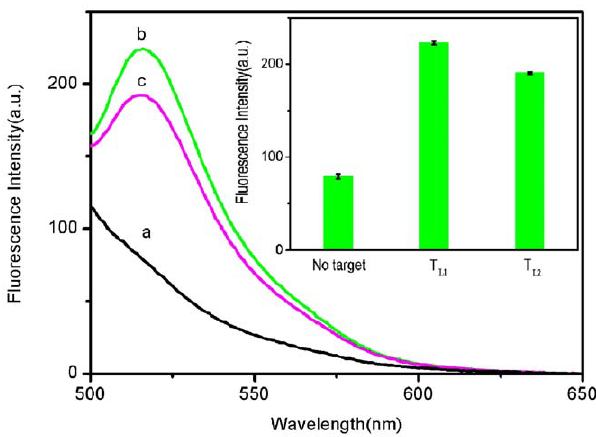
Figure 7. Evaluation of discrimination ability using longer target. Fluorescence emission spectra of P HIV (50 nM) in the presence of 40- m L RCPNs at different conditions: (a) P HIV -RCPN complex; (b) P HIV - RCPN complex + 300 nM T L1 ; (c) P HIV -RCPN complex + 300 nM T L2 . Inset: fluorescence intensity histograms with error bar. Excitation was at 480 nm, and the emission was monitored at 518 nm. All measurements were done in Tris-HCl buffer in the presence of 15 mM Mg 2 + (pH: 7.4). The error bar represents the standard deviation of three measurements.